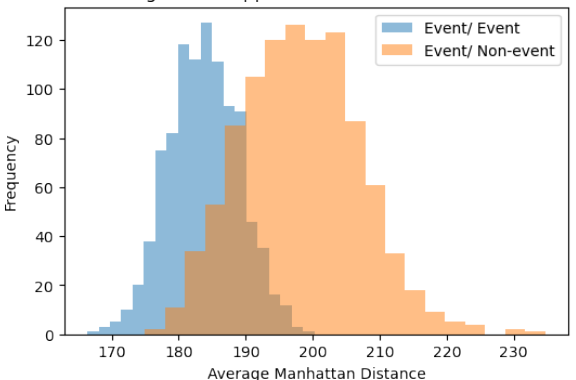
Figure 6. 9 × 9 Image Bootstrapped